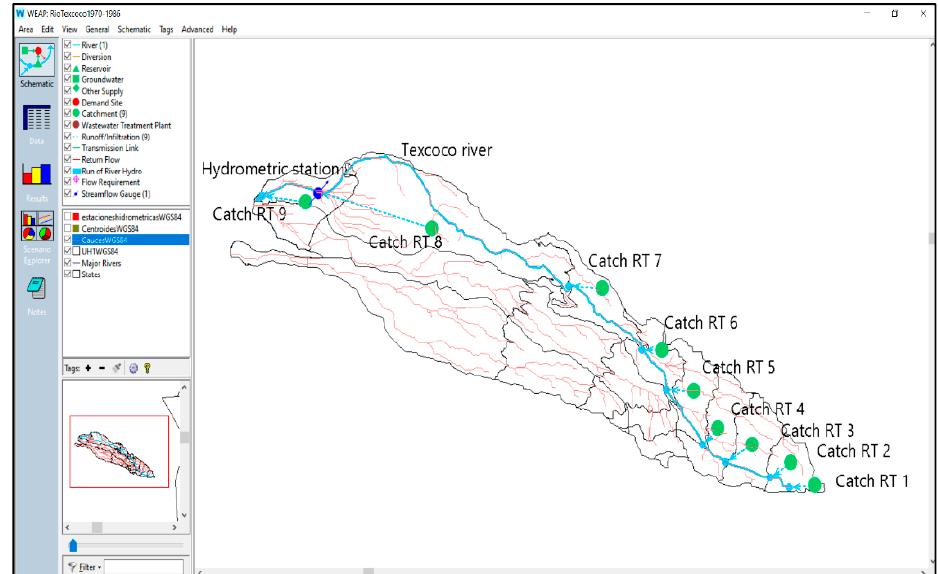
Figure 4. SIG ‐ WEAP feeding and planning